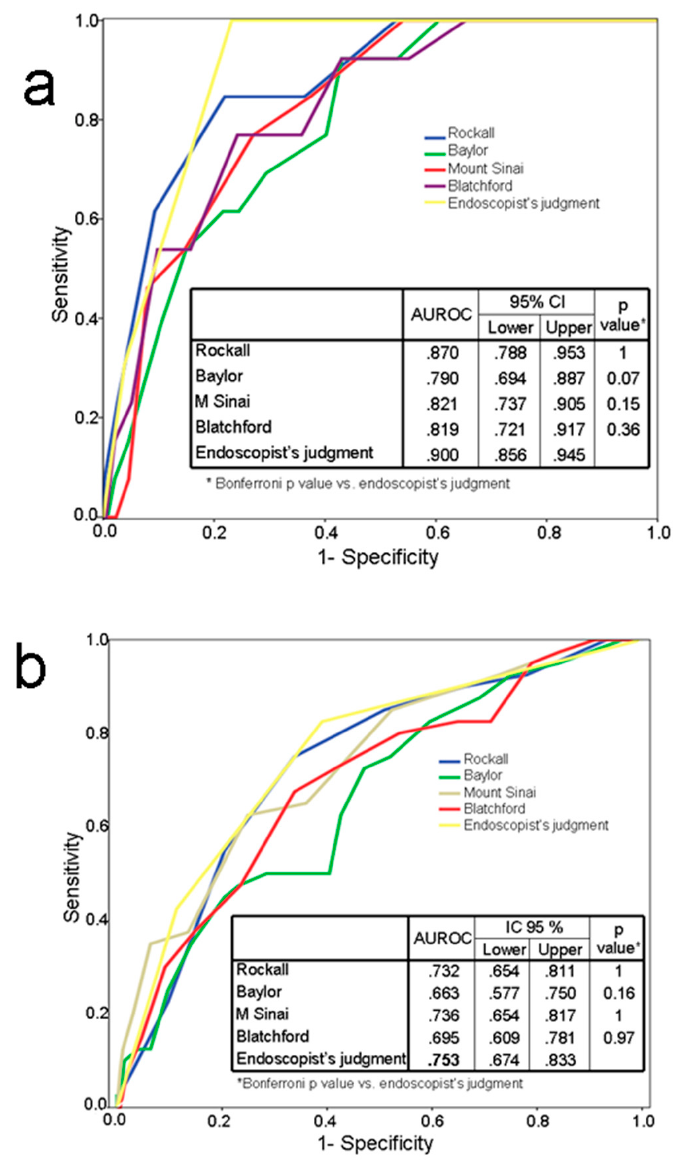
Figure 1. ( a ) Area under the receiver-operating-characteristics (ROC) curve for mortality. ( b ) Area under the ROC curve for rebleeding. All patients.